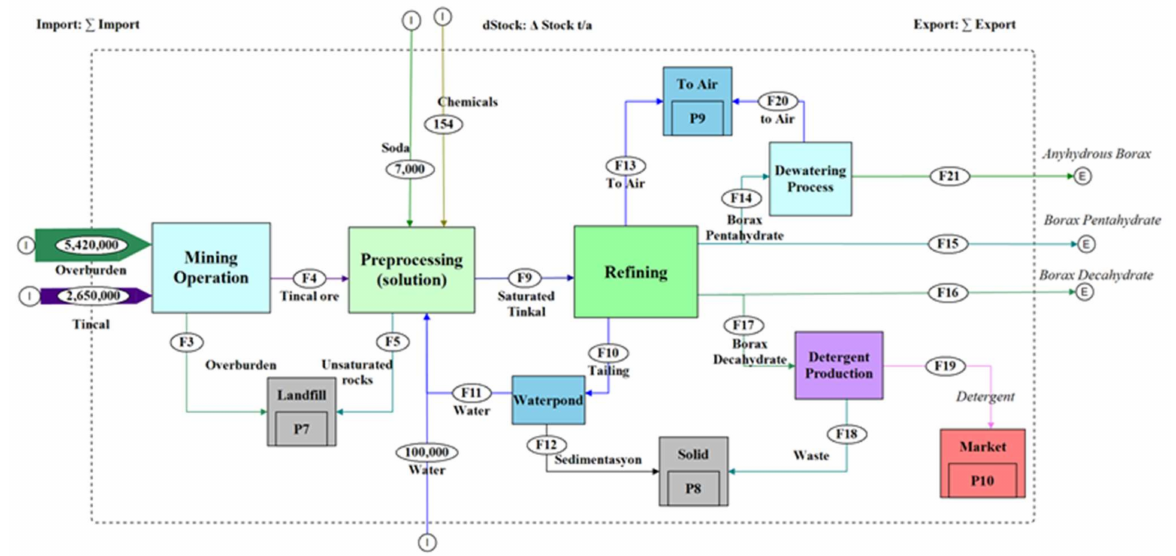
Figure 7. MFA modes of tincal and the processes and